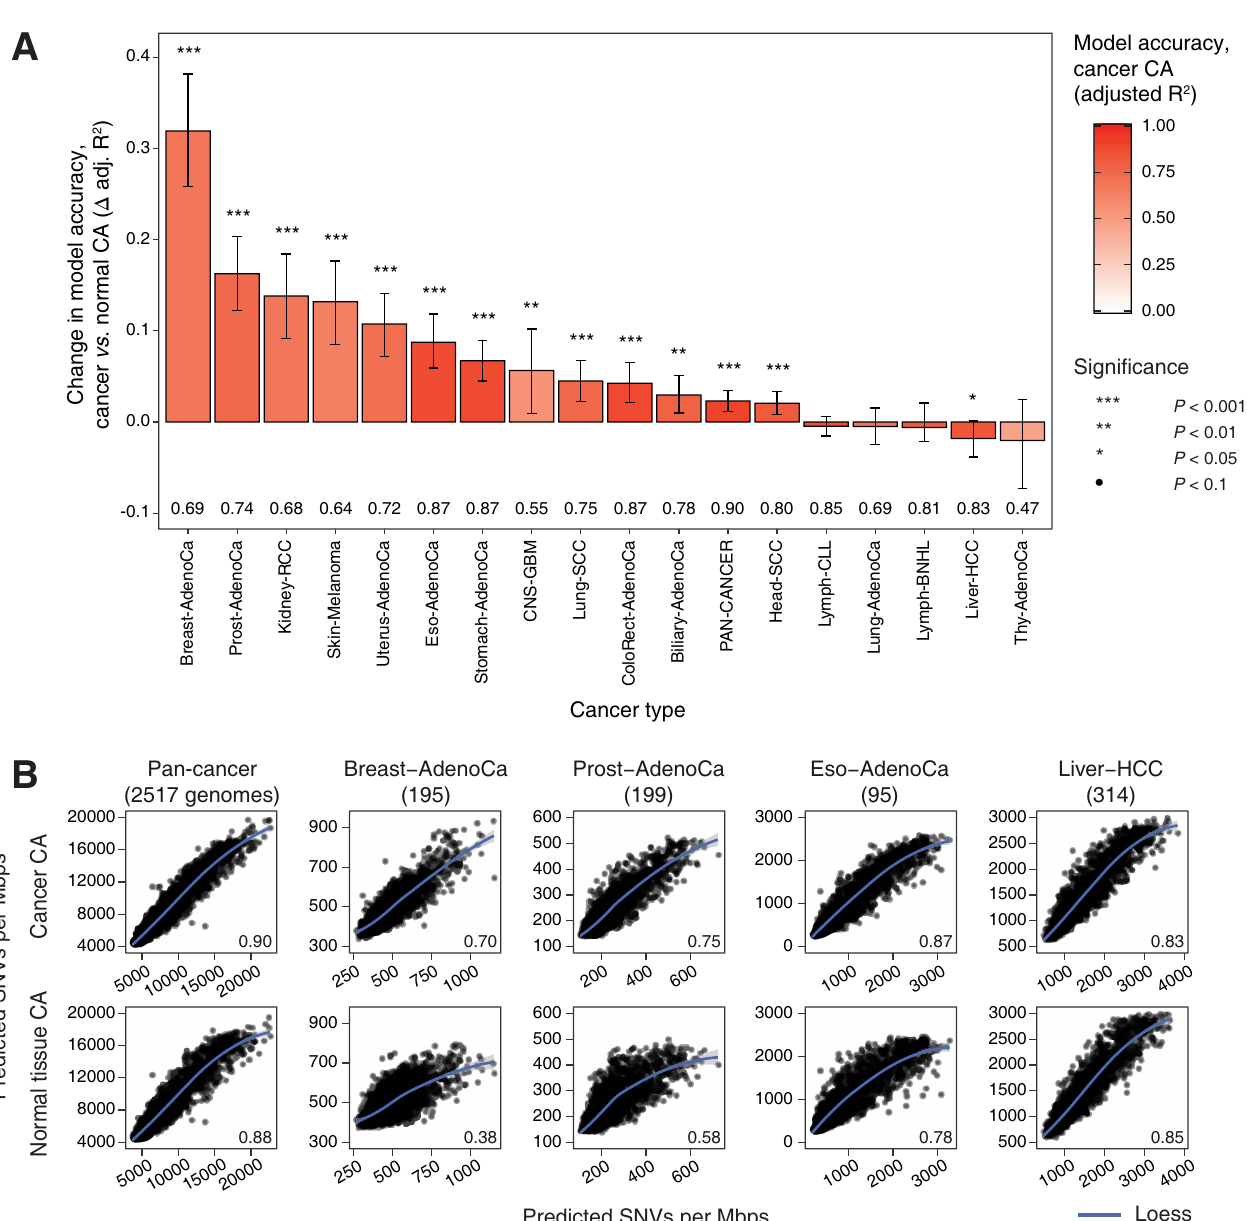
Fig 2. Chromatin accessibility profiles of primary cancers are stronger predictors of regional mutagenesis. A. Random forest models informed by CA profiles of primary cancers are more accurate predictors of regional mutation burden, compared to models informed by CA of normal tissues. Bar plot shows relative change in prediction accuracy ( Δ adjusted R 2 ) of random model regression models informed by CA profiles of primary cancers, compared to matching models informed by CA of normal tissues. Replication timing (RT) profiles are included in all models as reference. P-values of permutation tests and 95% confidence intervals from bootstrap analysis are shown. Accuracy values of models informed by cancer CA profiles are listed below the bars (adjusted R 2 ). B. Examples of regional mutation burden predicted using models informed by CA profiles of cancer (top) vs . CA profiles of normal tissues (bottom). Scatterplots show model-predicted and observed mutation burden (X vs . Y-axis) in one-megabase regions. Prediction accuracy values are shown (bottom right). https://doi.org/10.1371/journal.pcbi.1010393.g002 predictors for each cancer type from all 869 cancer and normal epigenomes (permutation P < 0.001). These 166 CA and RT profiles were quantified using Shapley additive explanation (SHAP) scores [40] that measured the directional associations of individual profiles with regional mutation burden in all genomic regions. As expected, regional mutation burden